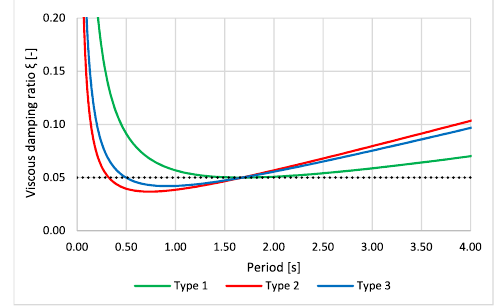
Figure 5. Viscous damping ratio as a function of the natural period